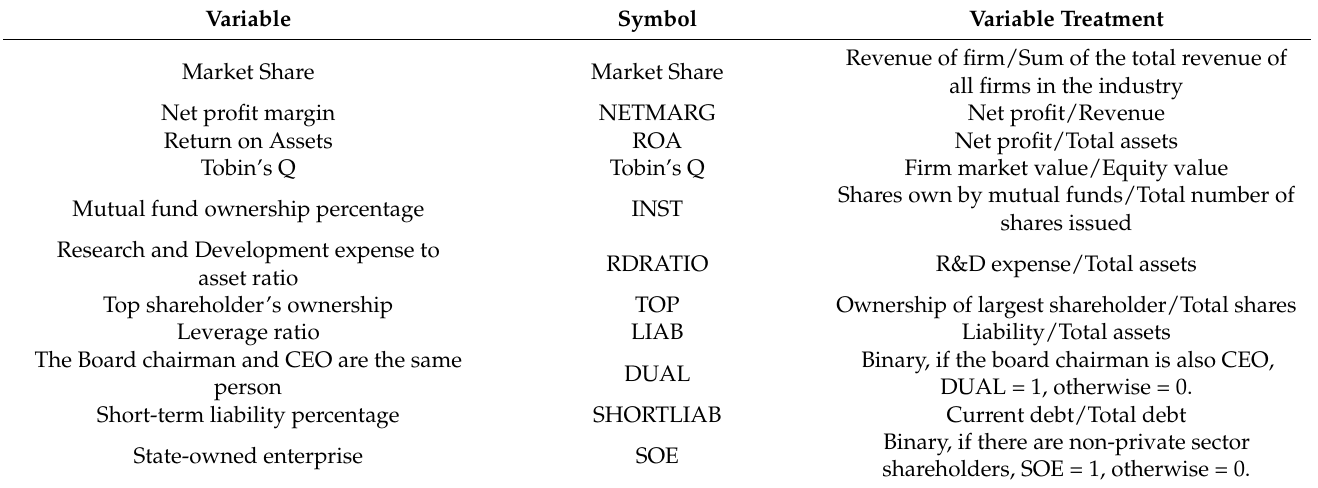
Table 2. Variable